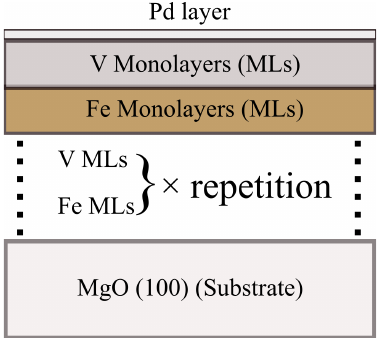
Figure 1. Schematic layout of the superlattice structure of the sample. The repetition is for the period of the number of V and Fe monolayers (Fe MLs/V MLs × repetition).